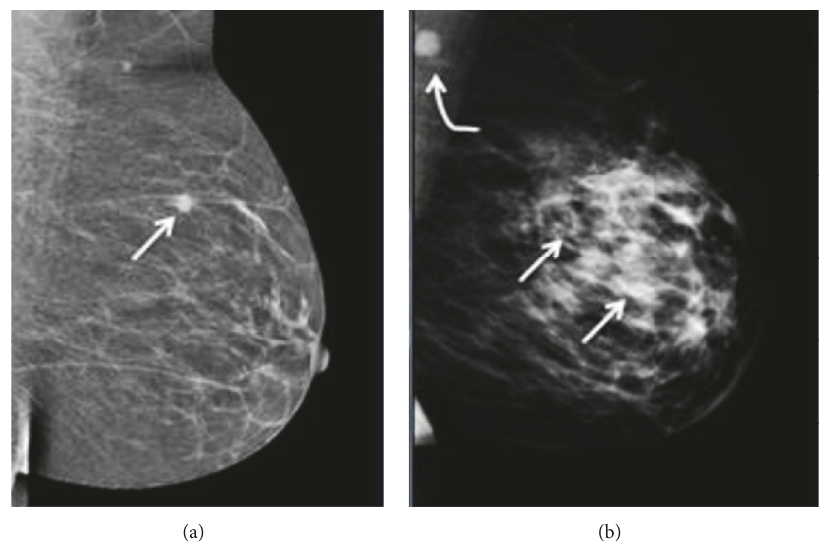
Figure 2: Mammogram images of a fatty breast and a heterogeneously dense breast [8]: (a) fatty breast with a small cancer (arrow), (b) heterogeneously dense breast with a 4 cm cancer (arrows) that is hidden by the dense breast tissue and notable metastatic node left of axilla (curved arrow). © 2015-2017, DenseBreast-info, Inc. and Dr. Regina Hooley.